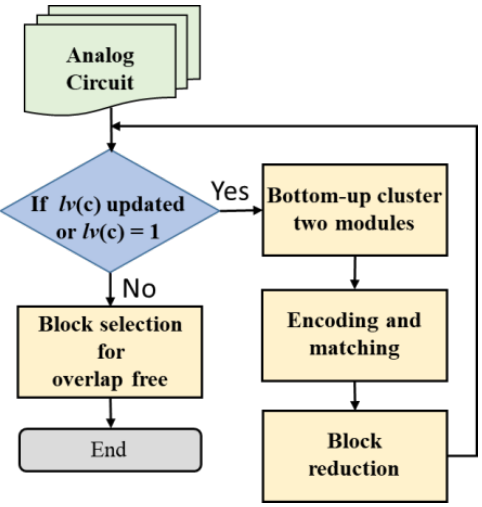
Figure 12. Overall flow of analog structure analysis.